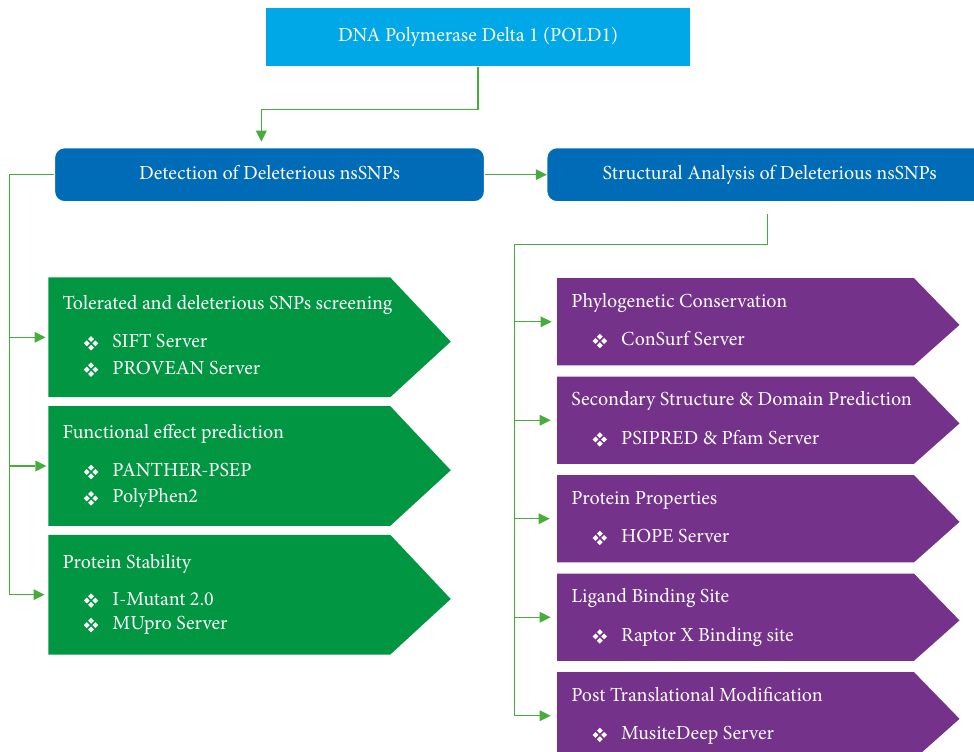
Figure 1: Schematic pipeline of the